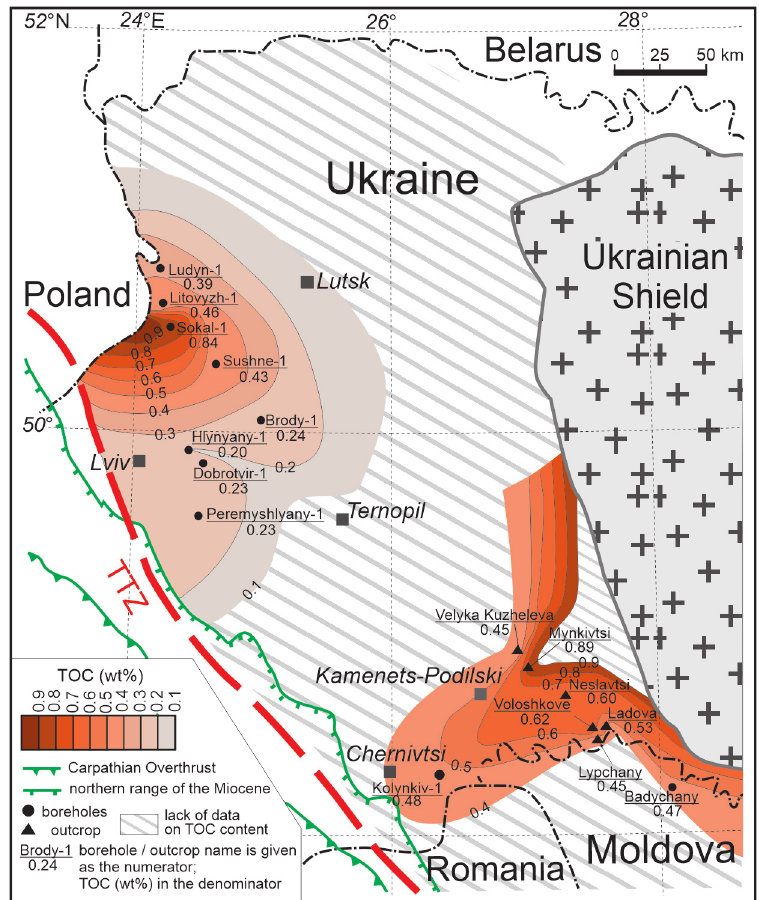
Fig. 8. Distribution of the TOC content in the Kalus Beds of the Volyn-Podillyan Plate and NW Moldovian